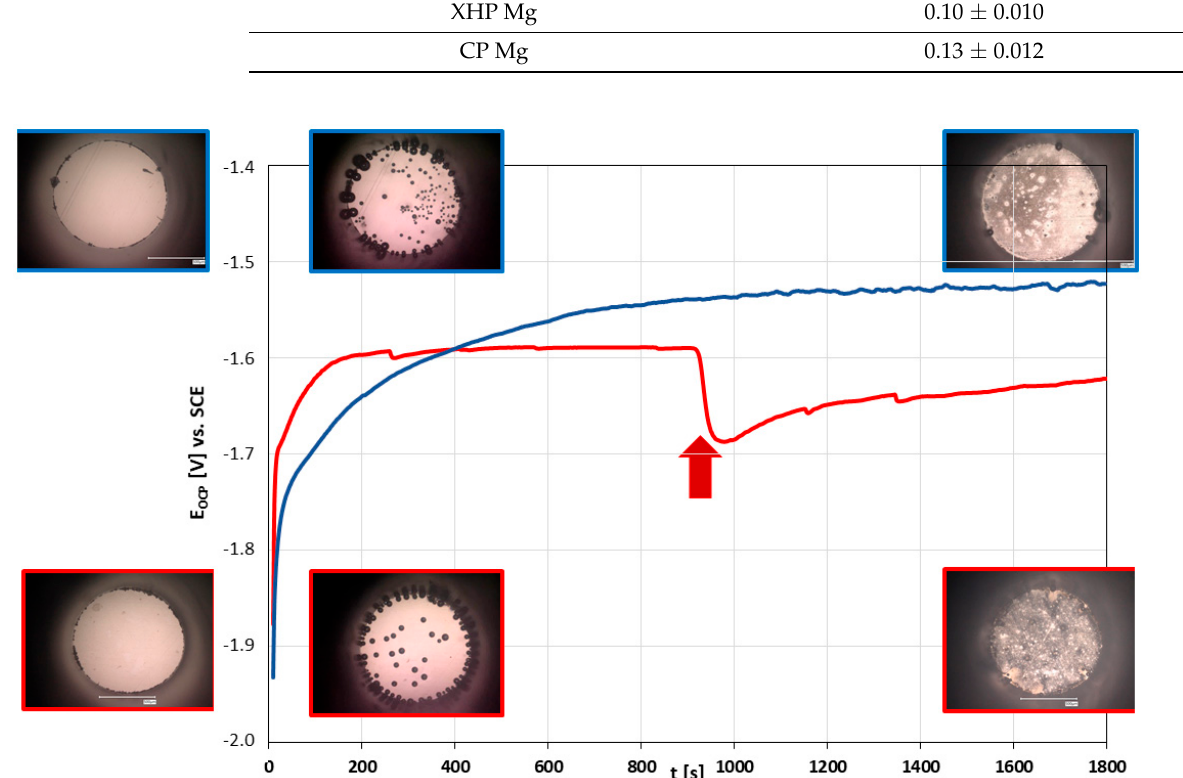
Figure 5. E OCP vs. t plots for XHP (red) and cp (blue) magnesium aligned with microscopic pictures (prior to contact with electrolyte, as well as at t = 0 and 30 min, after removal of the hydrogen bubbles); arrow: spontaneous detachment of large hydrogen bubble exposing fresh magnesium surface.